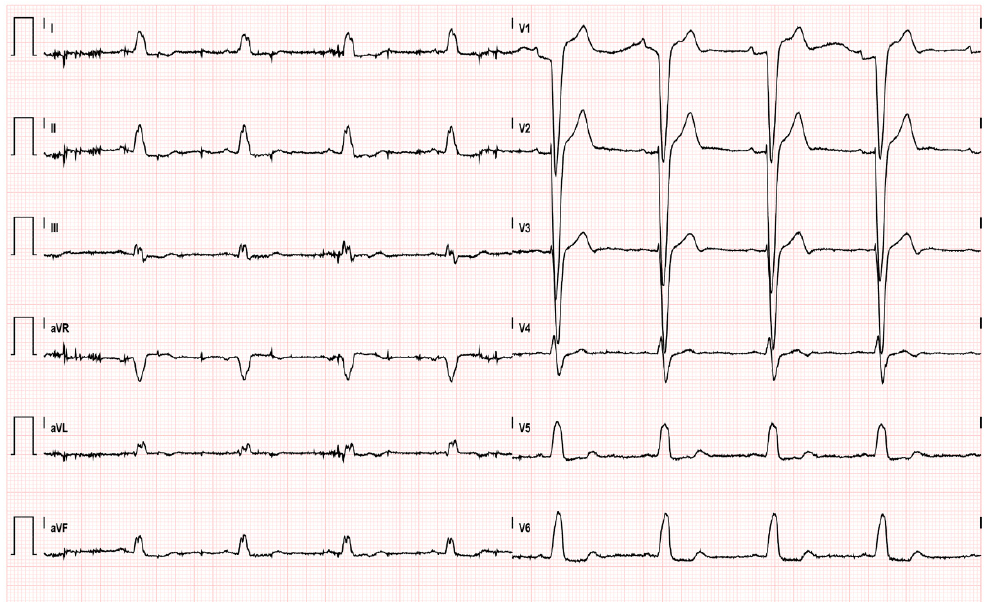
Figure 5. EKG after diltiazem administration.